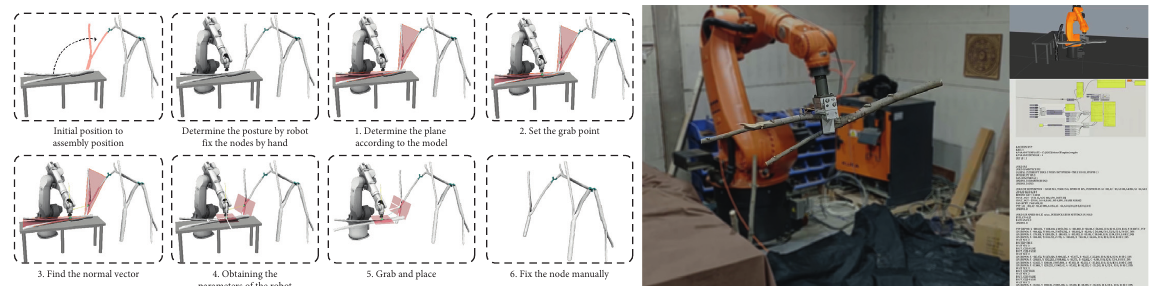
Figure 11: Robotic motion planning.